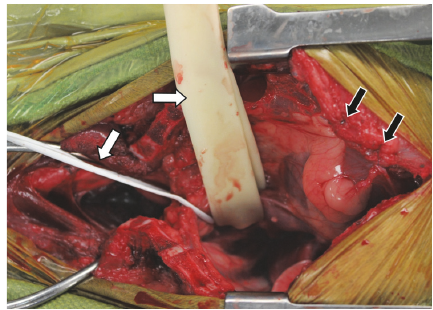
Figure 3: Intraoperative image. Black arrows denote sutures of the pericardial sling. White arrows denote Penrose tubing retracting vessels of the brachycephalic trunk.